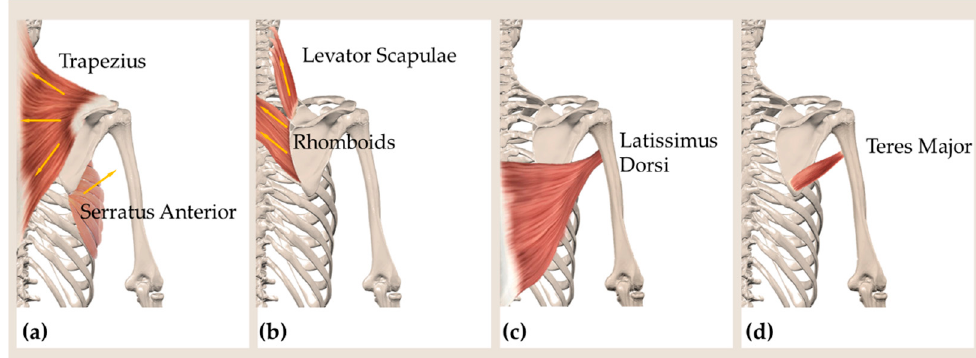
Figure 2. Drawing showing the main lines of action of ( a ) the muscles trapezius (upper, middle, lower fibers), serratus anterior; ( b ) rhomboids and levator scapulae. Posterior view showing the location of the muscles latissumus dorsi ( c ) and teres major ( d ), constituting the posterior border of the axillary region.